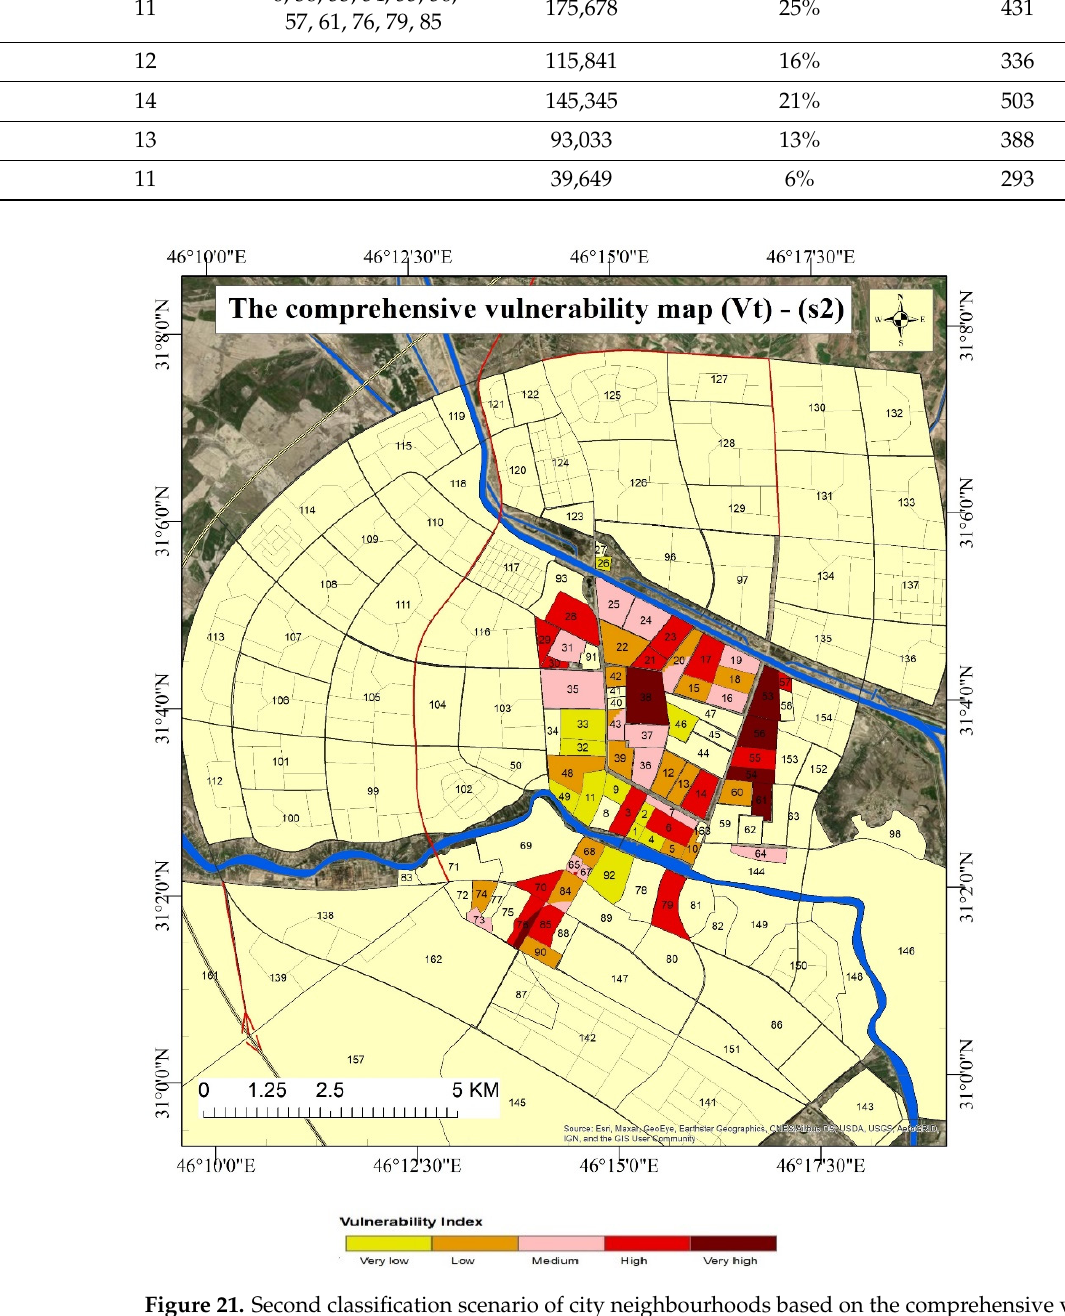
Figure 21. Second classification scenario of city neighbourhoods based on the comprehensive vulner- ability index (Vt).